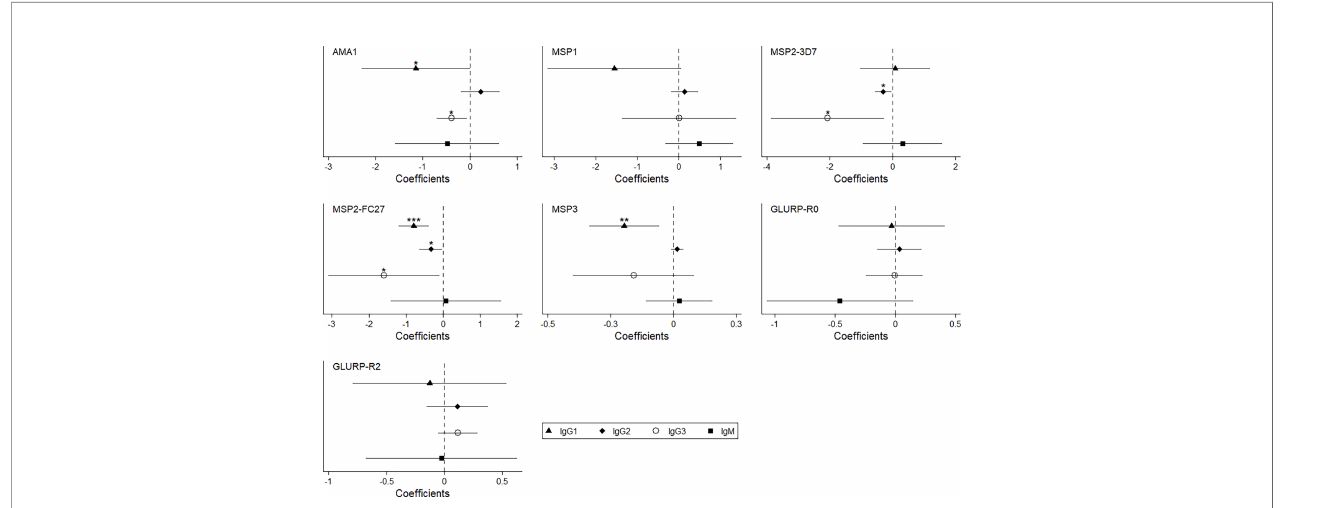
FIGURE 7 | Lower level of speci fi c anti-malarial IgG1 and IgG3 in infant born to women with PM and with malaria infection. This coefplot showed the synergic effect of PM and Pf active infection (interaction term) on the levels of anti-malarial antibodies in infant between 18 and 24 months of age. The models were adjusted on age, gender, birth weight, maternity, ethnicity, maternal anemia, maternal IPTp and spatiotemporal malaria exposure risk.